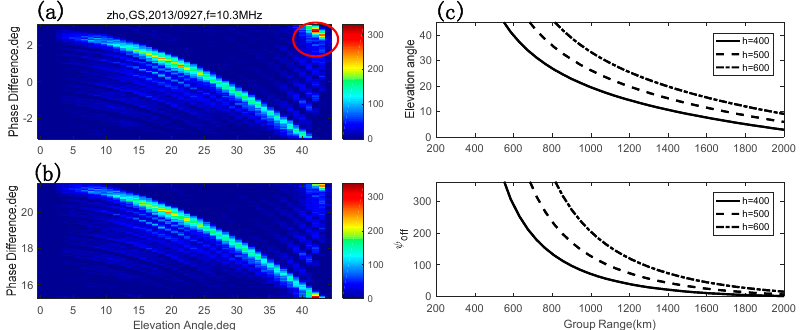
Figure 5. The same data as Figure 4, ( a ) the measured data and ( b ) the elevation–phase difference change with ambiguity factor added. ( c ) theoretical group range–elevation and group range–phase offset trends at h = 400, 500, and 600 km. The red circle in panel ( a ) shows ambiguity in the phase difference measurement.